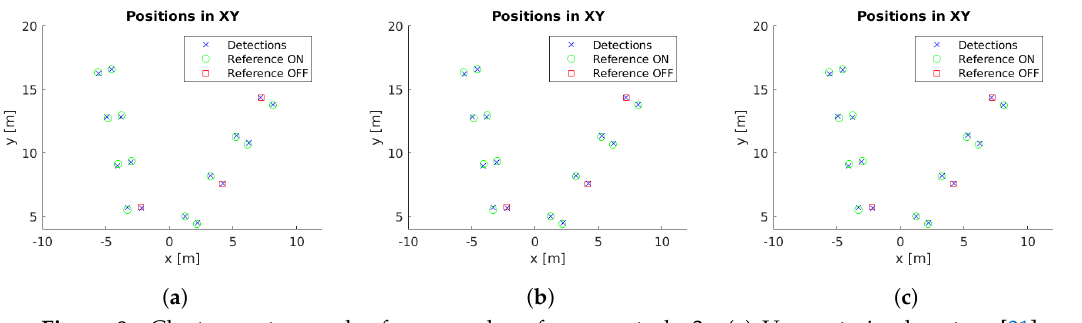
Figure 8. Cluster centers and reference values for case study 3. ( a ) Unconstrained system [31], ( b ) system with reprojection error filtering, and ( c ) system with filtering and orientation alignment..